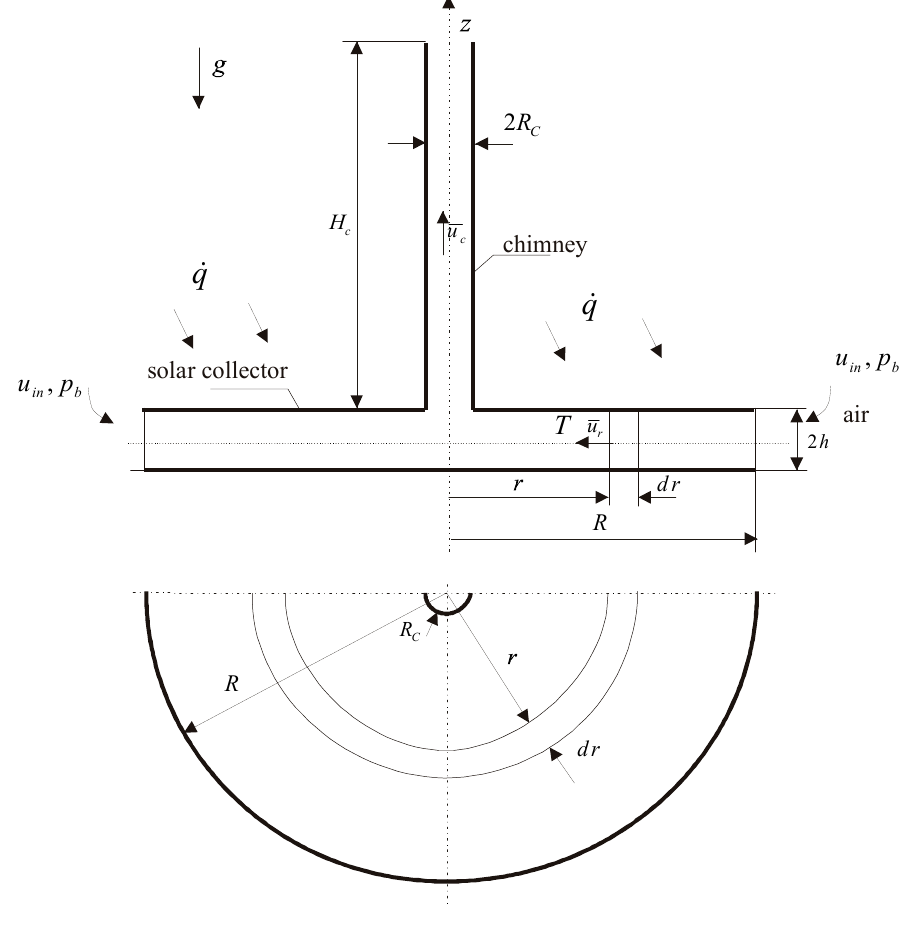
Figure 1. Solar chimney system.